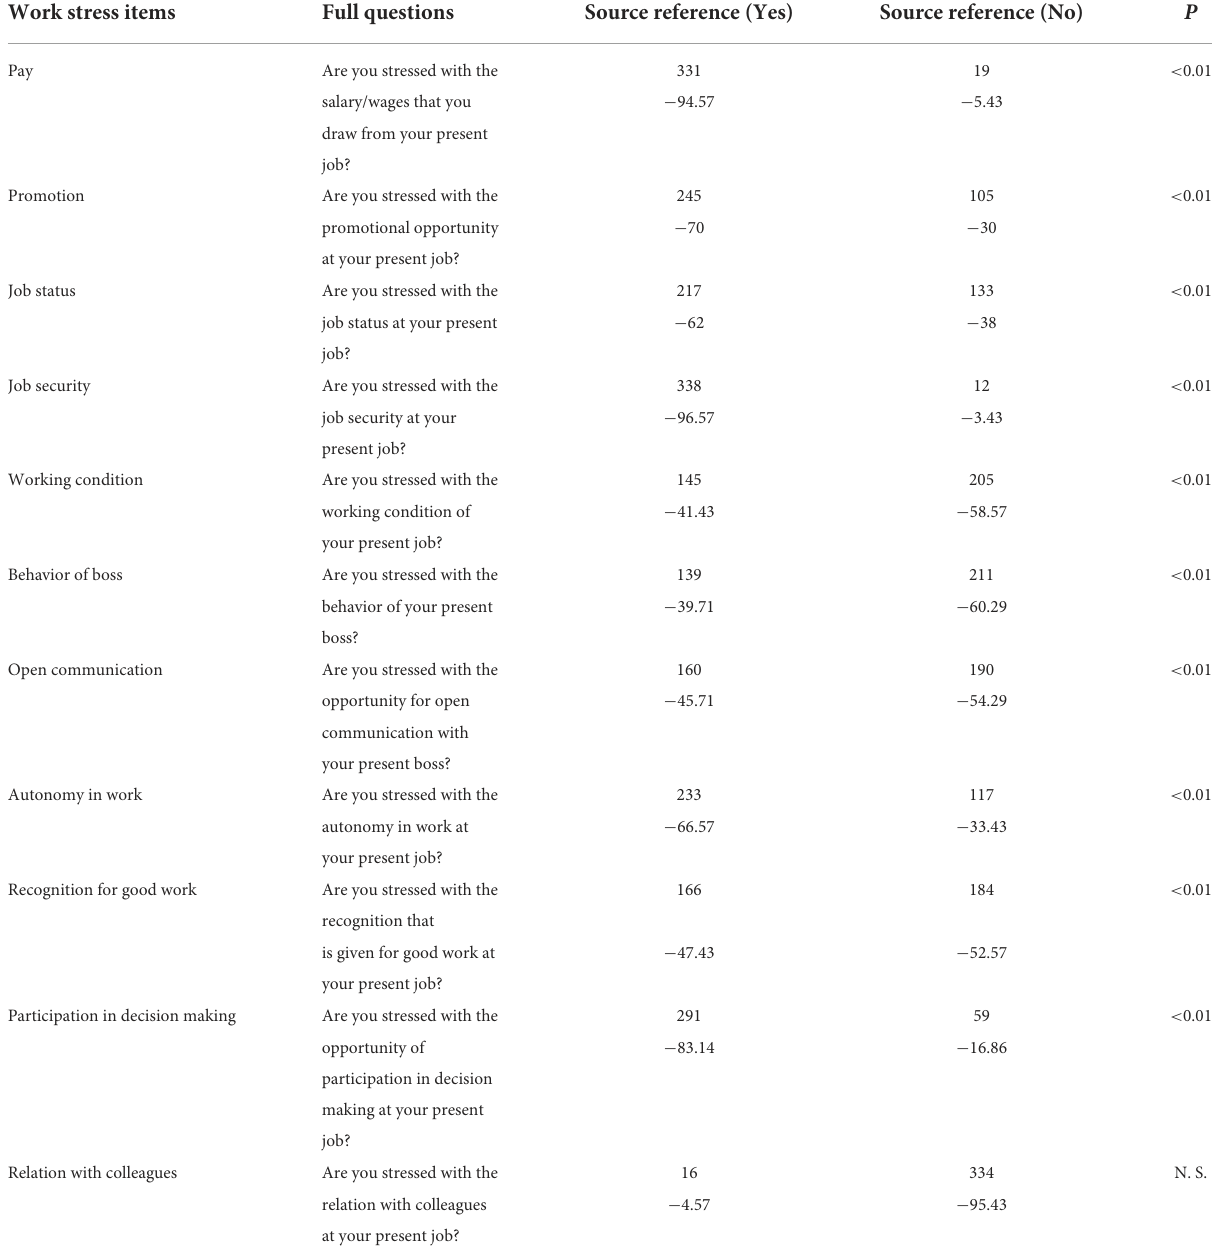
TABLE 9 Deals with individual occupational stress items ( n =